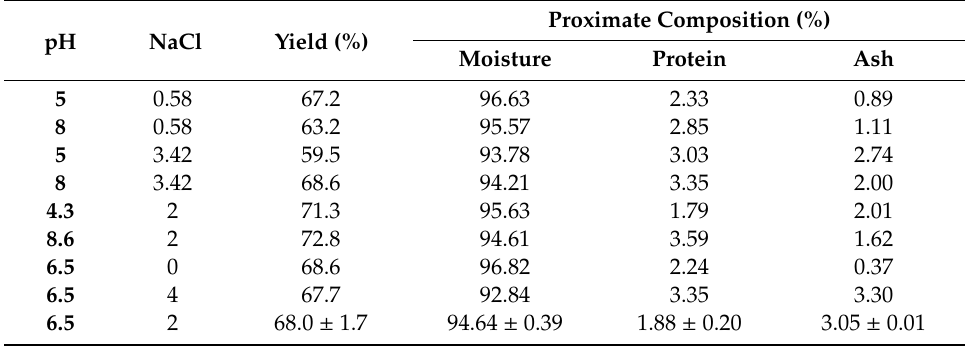
Table 3. Yield and proximate composition of soluble protein fractions from porcine heart as influenced by pH and NaCl content (%) of the extraction bu ff er. Proximate Composition (%) Yield (%) pH NaCl Moisture Protein Ash 0.58